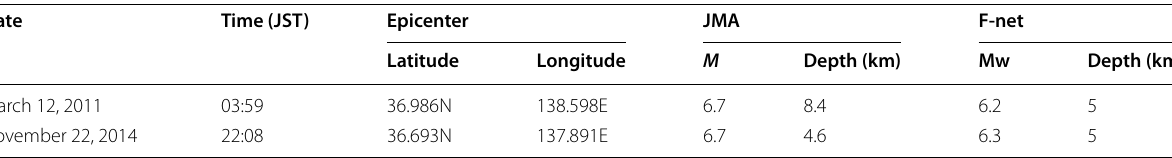
Table 1 Event source